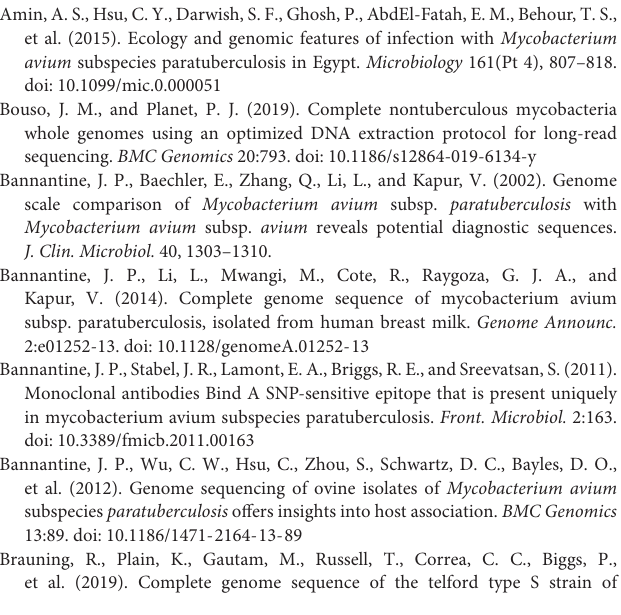
TABLE S7 | Core genes in Map as determined by Roary analysis. TABLE S8 | Core genes in non- Map as determined by Roary analysis. TABLE S9 | Map core genes present by PanOCT